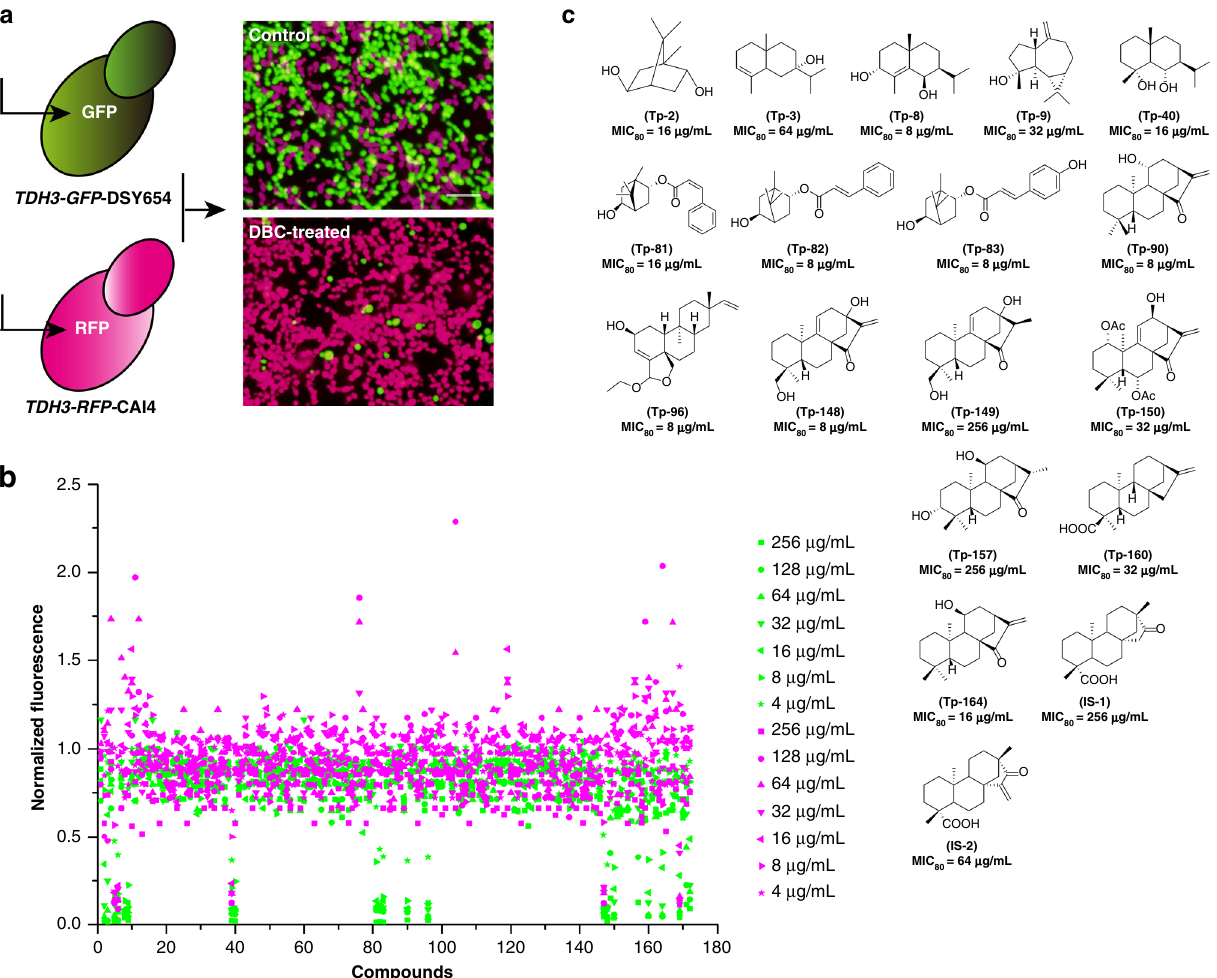
Fig. 1 Identi fi cation of PEPSs by screening a terpene library. a The C. albicans wild-type strain TDH3-RFP- CAI4 (shown in magenta) and Cdr-de fi cient strain TDH3-GFP- DSY654 (shown in green) were constructed for the co-culture assay. DBC, a representative PEPS, was used to demonstrate the validity of this assay. b Two fl uorescently labeled strains were equally mixed and exposed to two-fold serial dilutions of 172 terpenes ranging from 256 to 2 μ g/mL for 48 h at 30 °C. The GFP and RFP fl uorescence intensities were separately detected using a microplate reader. Agents that reduced either GFP or RFP fl uorescence intensity by more than 50% compared with the control group were characterized as hits. c The chemical structures of the PEPSs and their MIC values against the Cdr-de fi cient